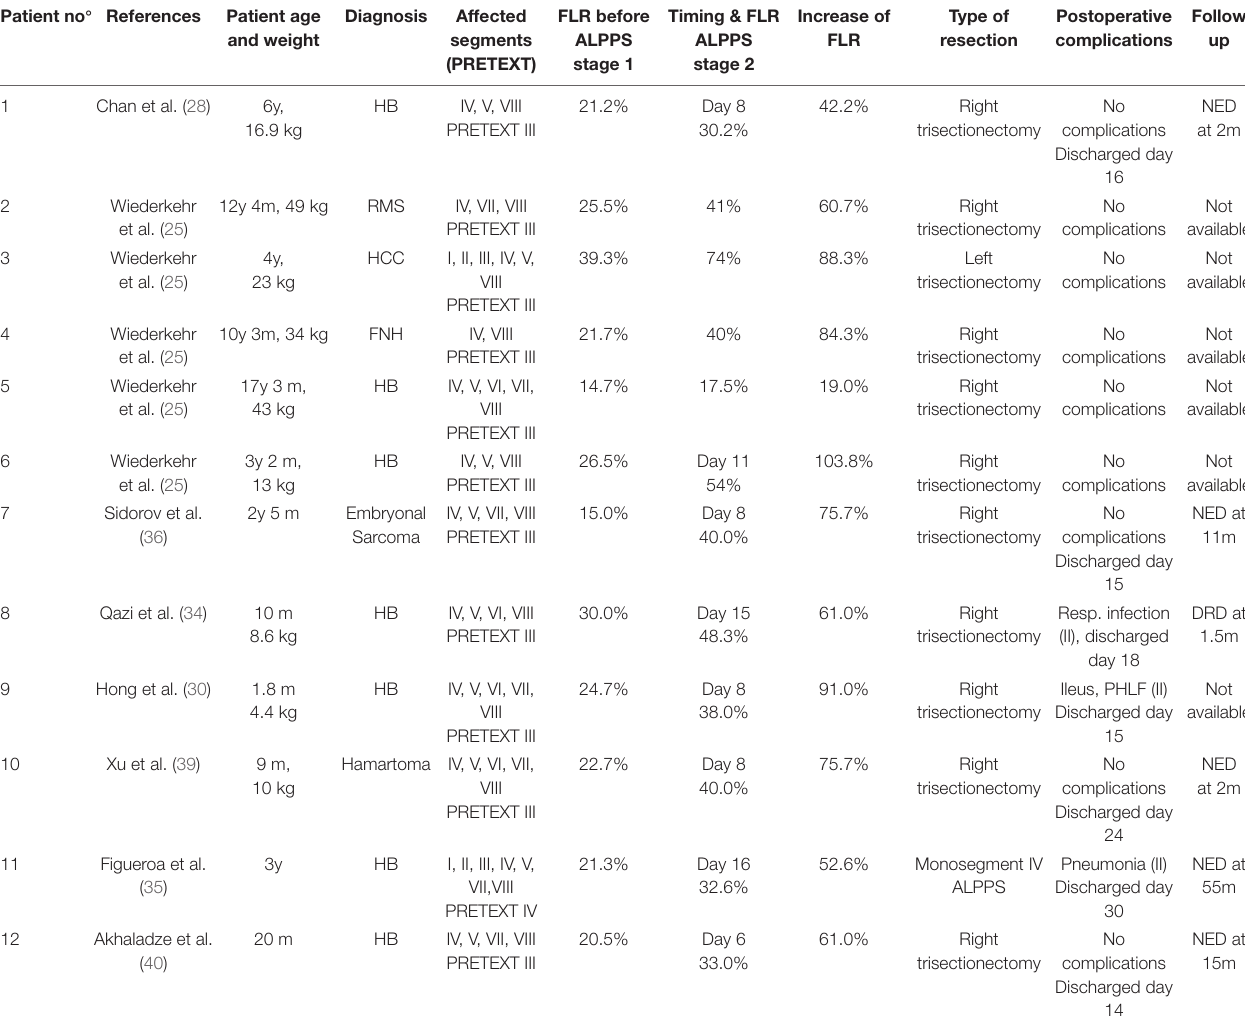
TABLE 2 | Overview of pediatric patients undergoing ALPPS. Patient no ◦